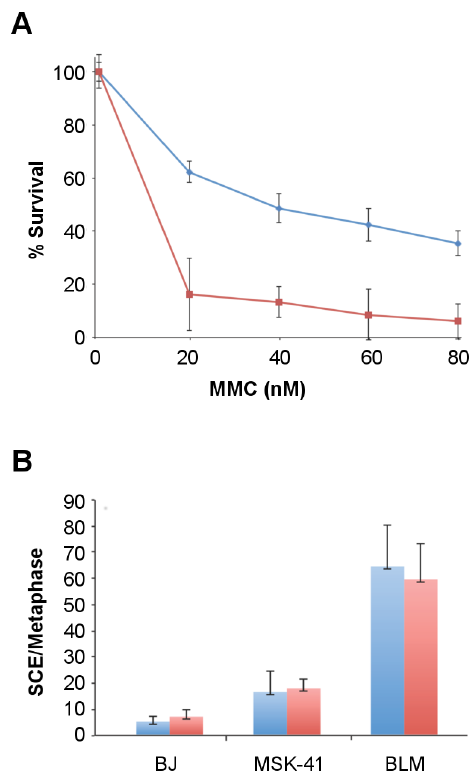
Figure 6. MSK-41 cells are hypersensitive to DNA damage and experience elevated levels of sister chromatid exchange. (A) BJ hTERT (blue line) and MSK-41 cells (red line) were treated at the indicated doses of mitomycin C (MMC) for 24 hours, and colony formation was scored 14 days post-treatment. Formation of at least 50 colonies was required at each dose for the experiment to be considered valid. (B) Spontaneous (blue) and MMC-induced (red) sister chromatid exchanges were visualized by Giemsa staining; the number of exchanges per metaphase is shown. Cells were cultured in 20 m M BrdU for 40 hours, with treatment with 25 ng/mL MMC for the final 24